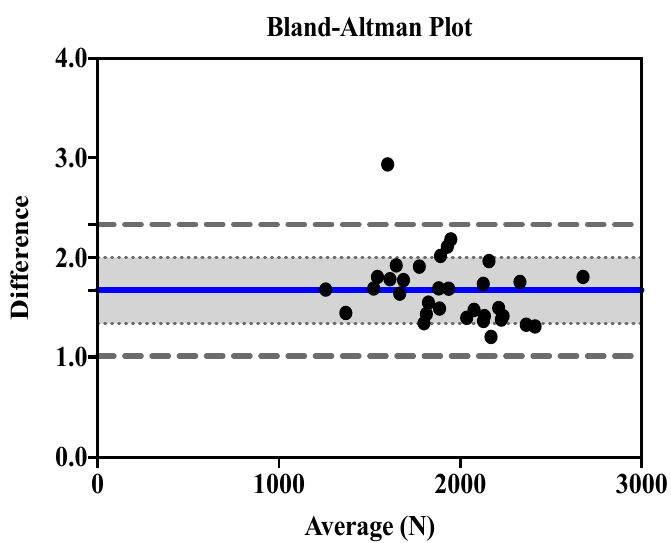
Figure 1. Bland‒Altman plot depicting the levels of agreement for the EccPF of the 1RM-BS and CMJ, including bias estimate (1.31) and both lower (0.88) and upper (1.74) limits of agreement.